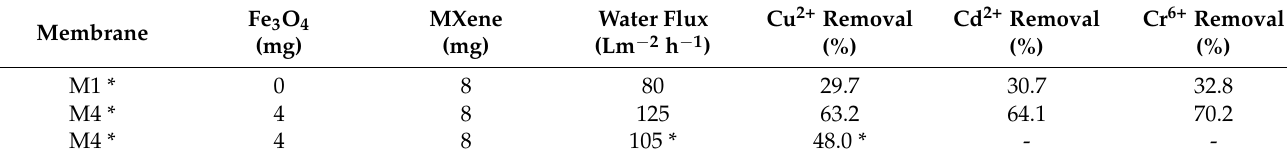
After three cycles of washing with HCl solution (pH = 3). * M1 and M4 = NF membrane prepared by adding Fe 3 O 4 -MXene nanosheets on commercial cellulose acetate membrane.